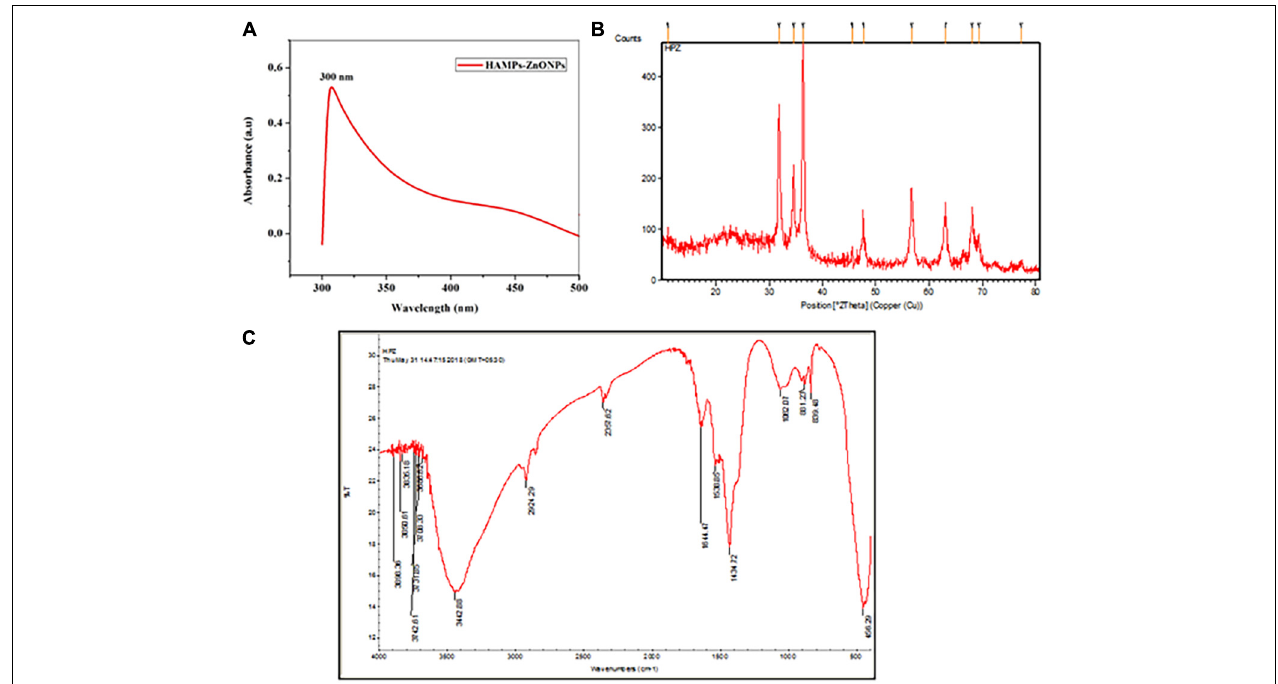
FIGURE 8 | (A) In the synthesized HAMP’s-ZnO NPs, the UV Spectroscopy spectrum shows a sharp peak at 300 nm. (B) The reflection peaks of the synthesized HAMP Zinc oxide nanoparticles can be seen in the XRD spectrum. (C) The peaks of the functional groups of the synthesized Zinc oxide nanoparticles can be seen in the FTIR